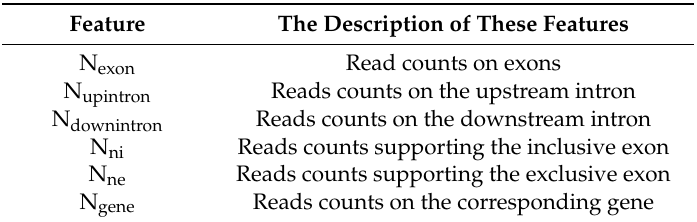
Table 6. The description of the six basic features.